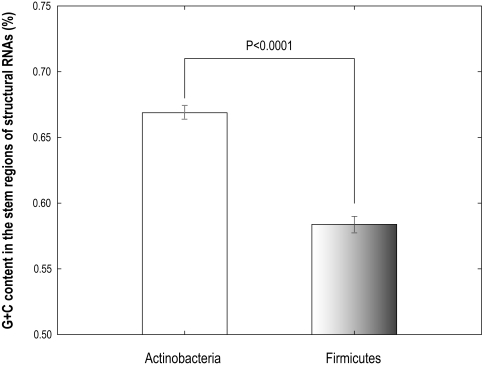
Comparison of G+C content in the stem regions of structural RNAs in Actinobacteria and Firmicutes.In this figure, data represent mean±standard deviation of G+C content in the stem regions from species in these two phyla respectively. The result of the comparison shows that species from Actinobacteria has a higher G+C content in the double-stranded stem regions of structural RNAs (mean = 0.669, standard deviation = 0.044) than those from Firmicutes (mean = 0.583, standard deviation = 0.063).